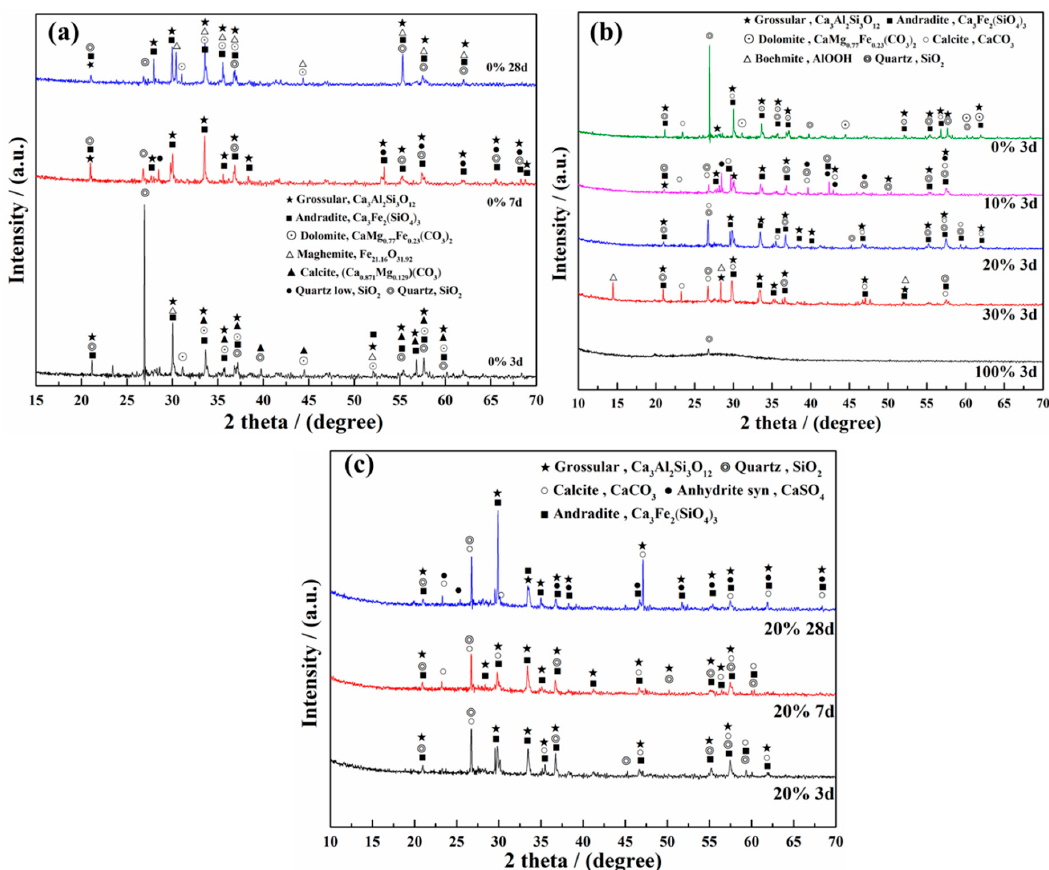
Figure 5. The X-ray diffraction patterns of GTGs-0 after 3, 7, and 28 days of curing ( a ), GTGs-1, GTGs-2 and GTGs-3 for 3 days compared to the GTGs-0 and GTGs-4 ( b ), and GTGs-2 after 3, 7, and 28 days of curing ( c ), respectively.